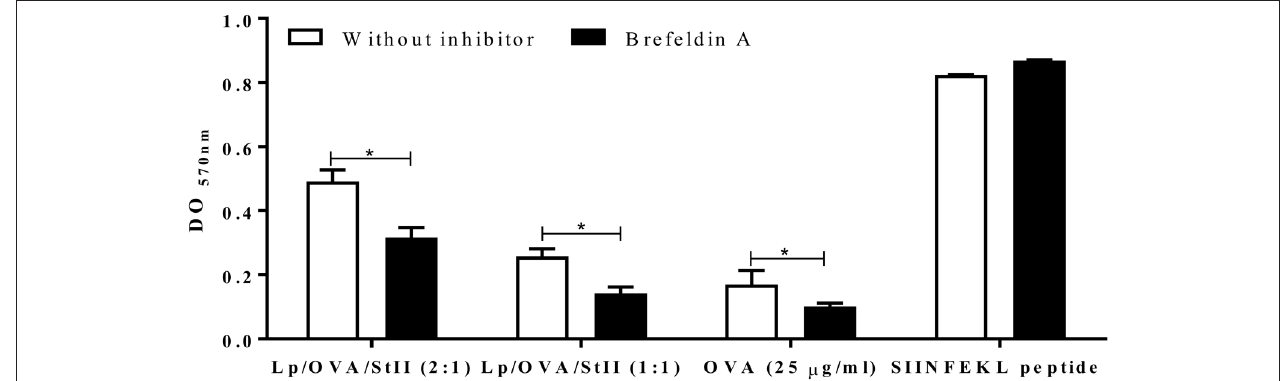
FIGURE 6 | Nascent MHC class I molecules are partially required for antigen cross-presentation induced by StII co-encapsulated with OVA into liposomes. Bone marrow-derived macrophages (BM-M 8 s) were pre-incubated with 5 µ g/mL brefeldin A (BFA) and stimulated with OVA co-encapsulated with StII into liposomes composed by DPPC and Chol in 2:1 or 1:1 ratios [Lp/OVA/StII (2:1) and Lp/OVA/StII (1:1)] at final concentrations of 0.8 µ g/ml and 0.1 µ g/ml of each protein, respectively. After stimulation cells were washed and co-cultured with B3Z CD8 + T cells. β -galactosidase activity of the B3Z CD8 + T cells was determined by a colorimetric assay. Mean and SEM of OD 570nm of two independent experiments are shown. Statistical analysis was performed with Mann–Whitney U-test: * p <